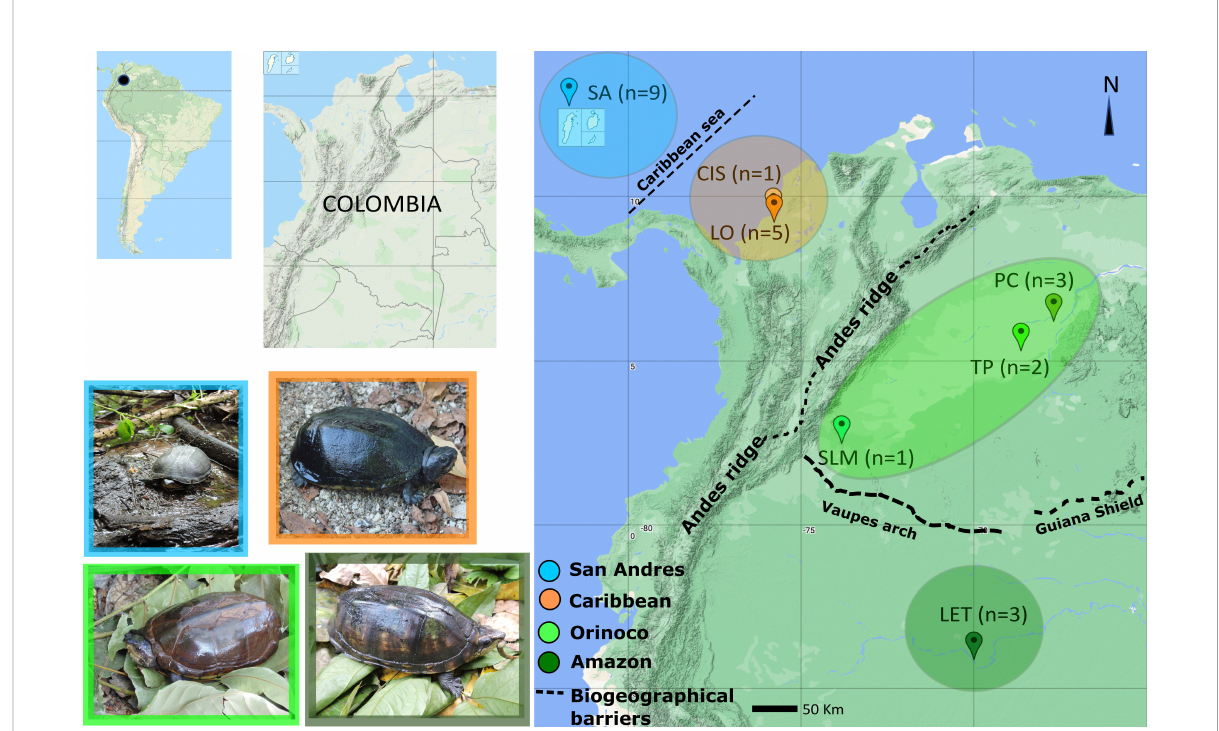
FIGURE 1 Map of Kinosternon scorpioides tissue sampling sites and sizes in insular and continental areas: SA (San Andre ́ s Island, San Andre ́ s and Providencia Archipelago), CIS (Cispata ́ Bay, Cordoba Province), LO (Lorica Swamp, Cordoba Province), PC (Puerto Carreño, Vichada Province), TP (Tuparro National Park, Vichada Province), SLM (Serran ı ́ a la Macarena, Meta Province), and LET (Leticia, Amazonas Province). Pictures of sampled individuals from each area are